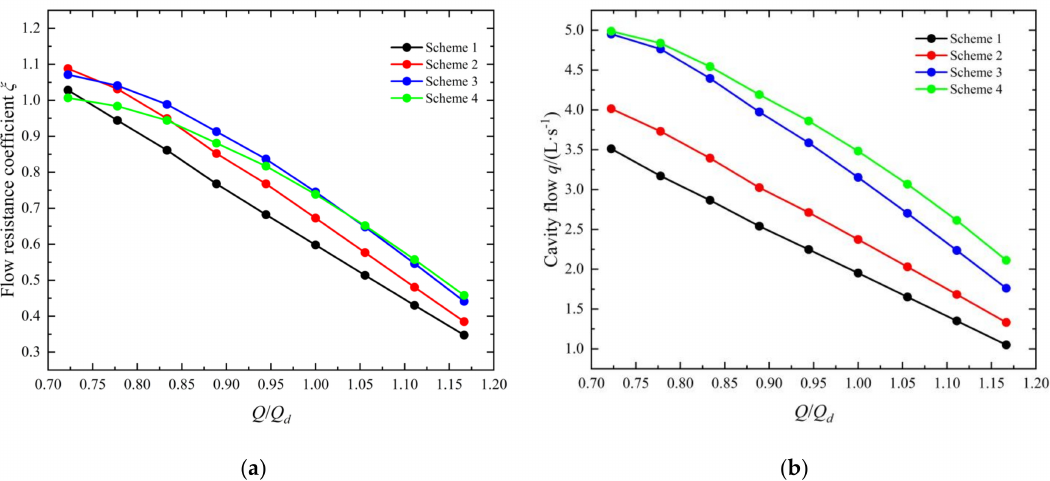
Figure 19. Flow resistance coefficient and cavity flow of rotor with different schemes. ( a ) The flow resistance coefficient, ( b ) The cavity flow.